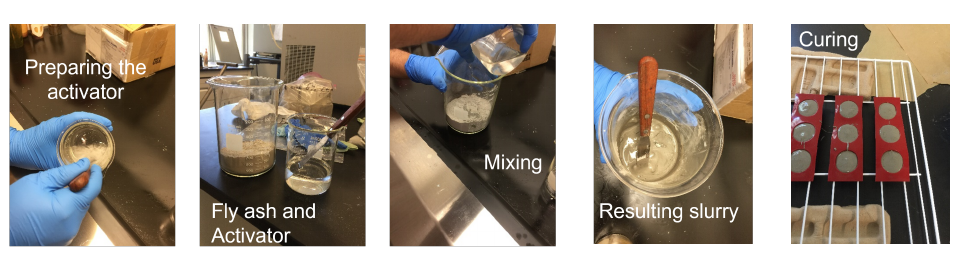
Figure 1. Geopolymer preparation.